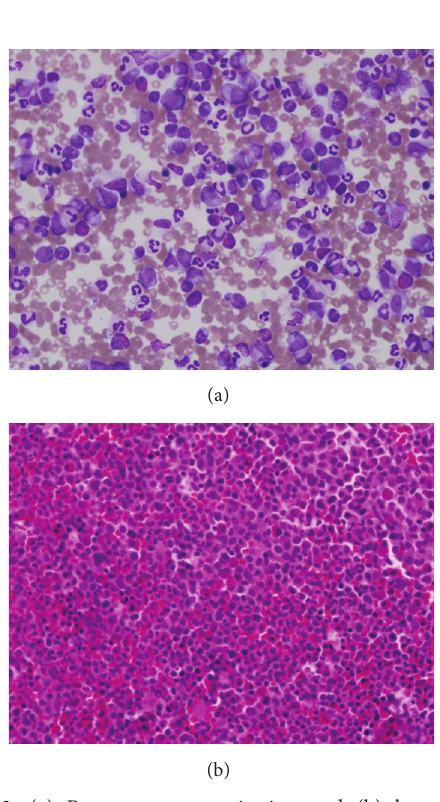
Figure 2: (a) Bone marrow aspiration and (b) bone marrow biopsy show increased cellularity, decreased erythroid precursors, and increased myeloid precursors with progressive and orderly maturation.